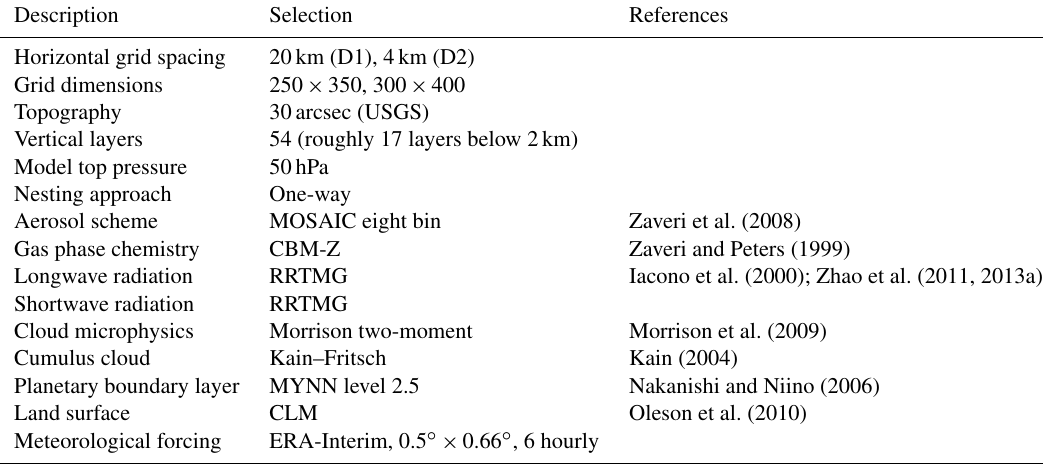
Table 1. Summary of model